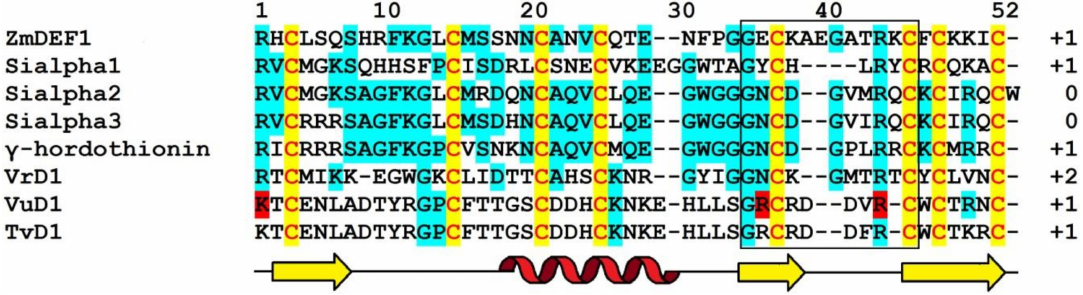
Figure 7. Sequence alignment of grass defensins with α -amylase inhibitory activity. VrD1, VuD1, and TvD1 defensins are included for comparison. Cysteine residues are shaded yellow, while identical amino acids are shaded cyan. Functionally significant residues are highlighted in red [51]. The position of β -strands (yellow) and the α -helix (red) are indicated below the figure. A black frame borders the γ -core. The γ -core charge values are shown on the